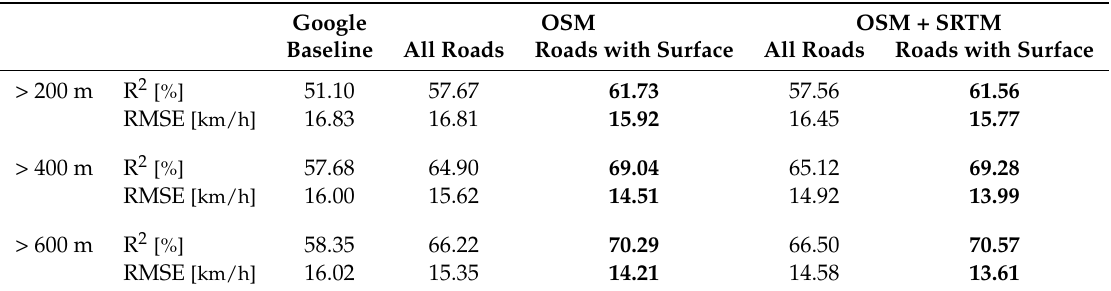
Table 4. Comparison of the R 2 and RMSE of NNSW (Australia) for all links over 200m, 400m and 600m, respectively. The maximum value of each row with only OSM data and with OSM and SRTM data is highlighted in bold.